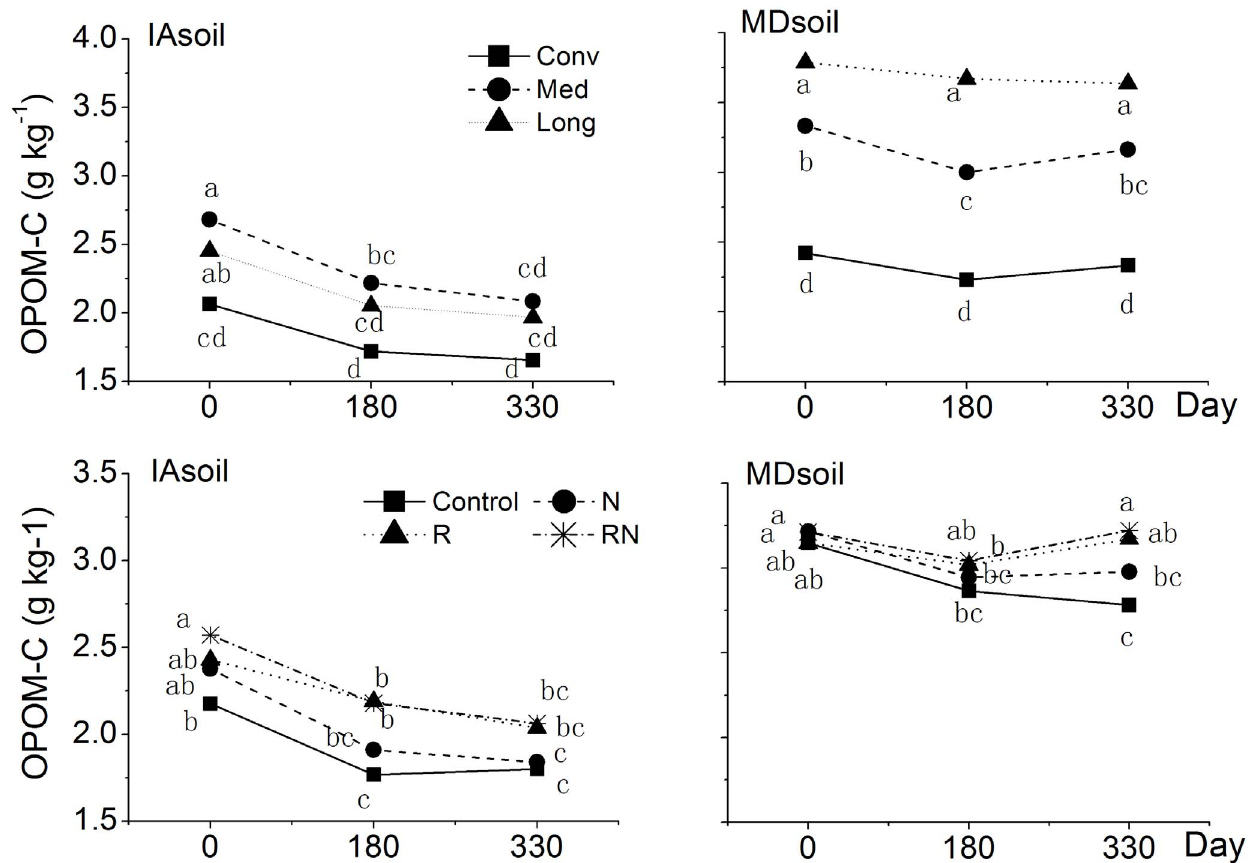
Figure 3. Effect of cropping system and treatment on occluded POM-C (OPOM-C) dynamics during 330 day incubation. Control: treatments with no residue nor N fertilizer added. N: treatments with N fertilized, R: treatments with residue applied. RN: treatments with both residue and N fertilizer added. Different letters suggest significant differences at p , 0.05, comparisons were were made for the interaction of cropping system (Conv, Med, Long) by date (0, 180, 330 days), and treatments (Control, N, R, RN) by date within each site (IAsoil, MDsoil).